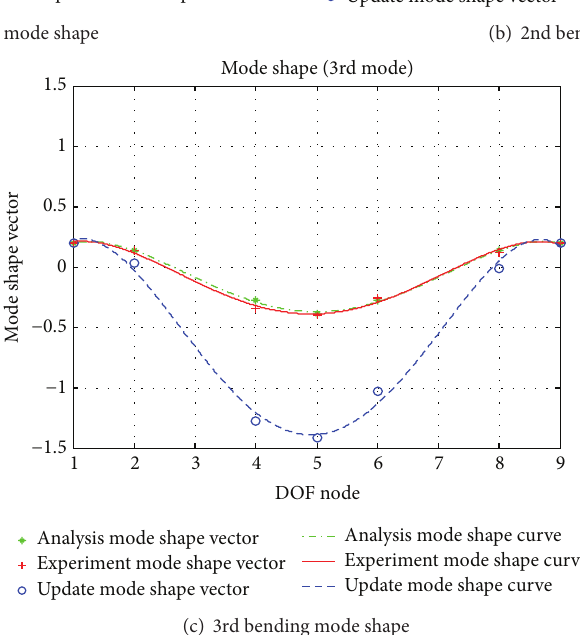
Figure 10: Comparison of 7 DOF analysis, updating, and experimental mode